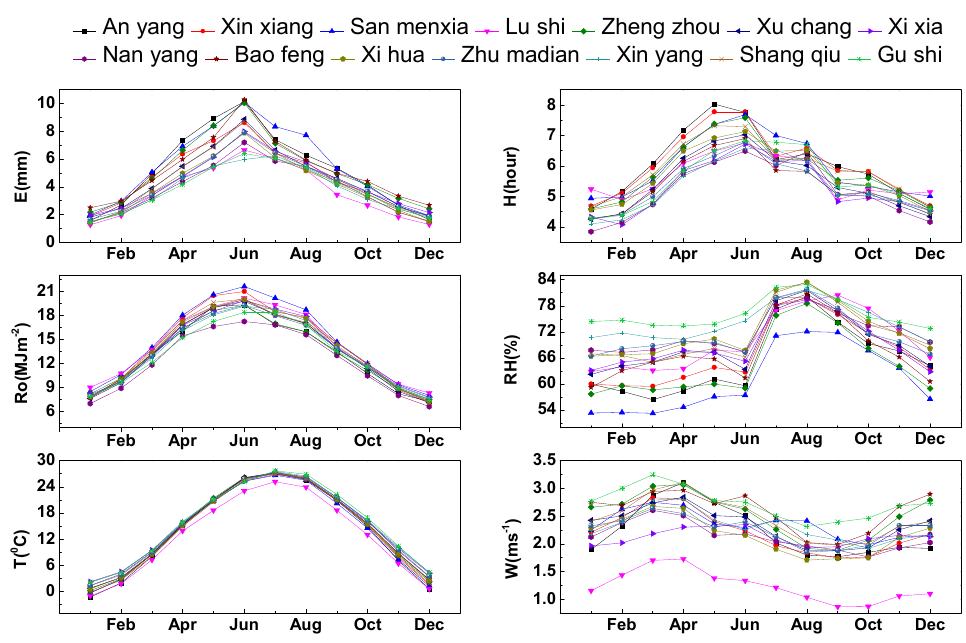
Figure 3. Seasonal variation trend of meteorological variables in each station.